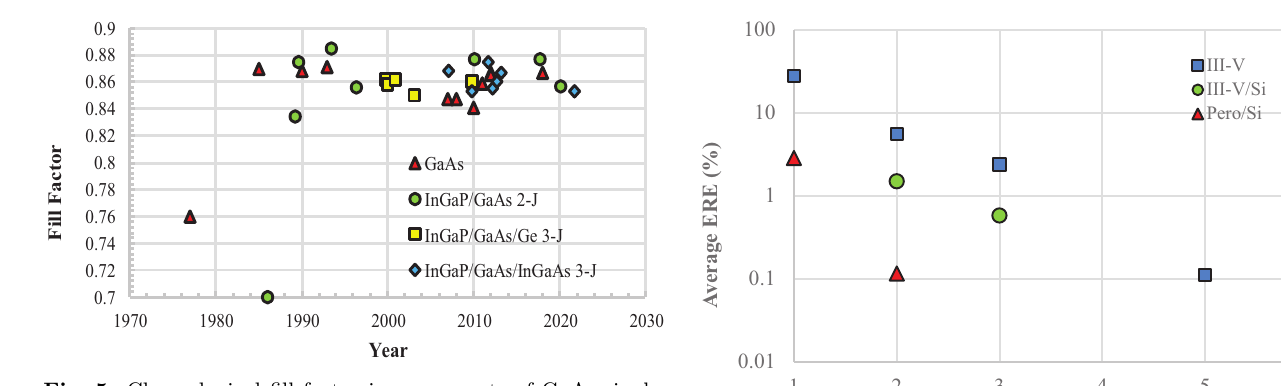
Fig. 5. Chronological fi ll factor improvements of GaAs single- junction, III – V 2-junction, III – V/Ge 3-junction and III – V/ InGaAs 3-junction solar cells.